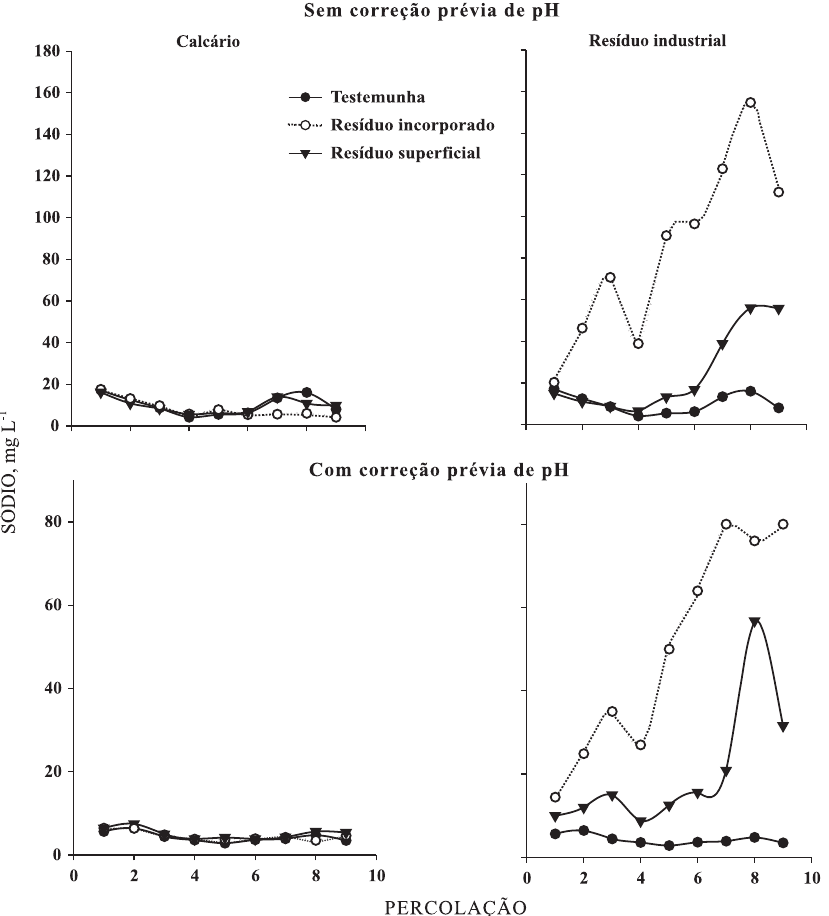
Figura 2. Flutuação temporal da concentração de sódio na solução percolada em cada uma das 10 percolações com água destilada em função de formas de aplicação de calcário ou de um resíduo industrial em amostras de solo com e sem correção prévia de